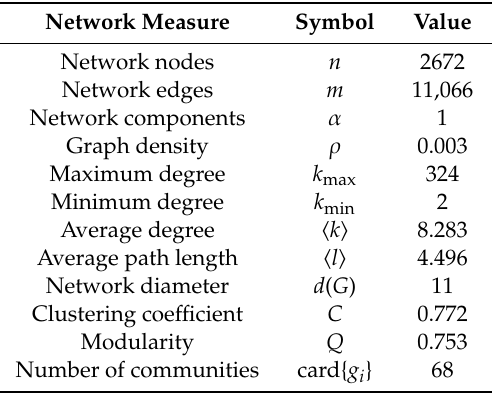
Table 2. Results of the network measures of the visibility graph associated to the available voltage oscillation time-series of TlInTe 2 (see Figure